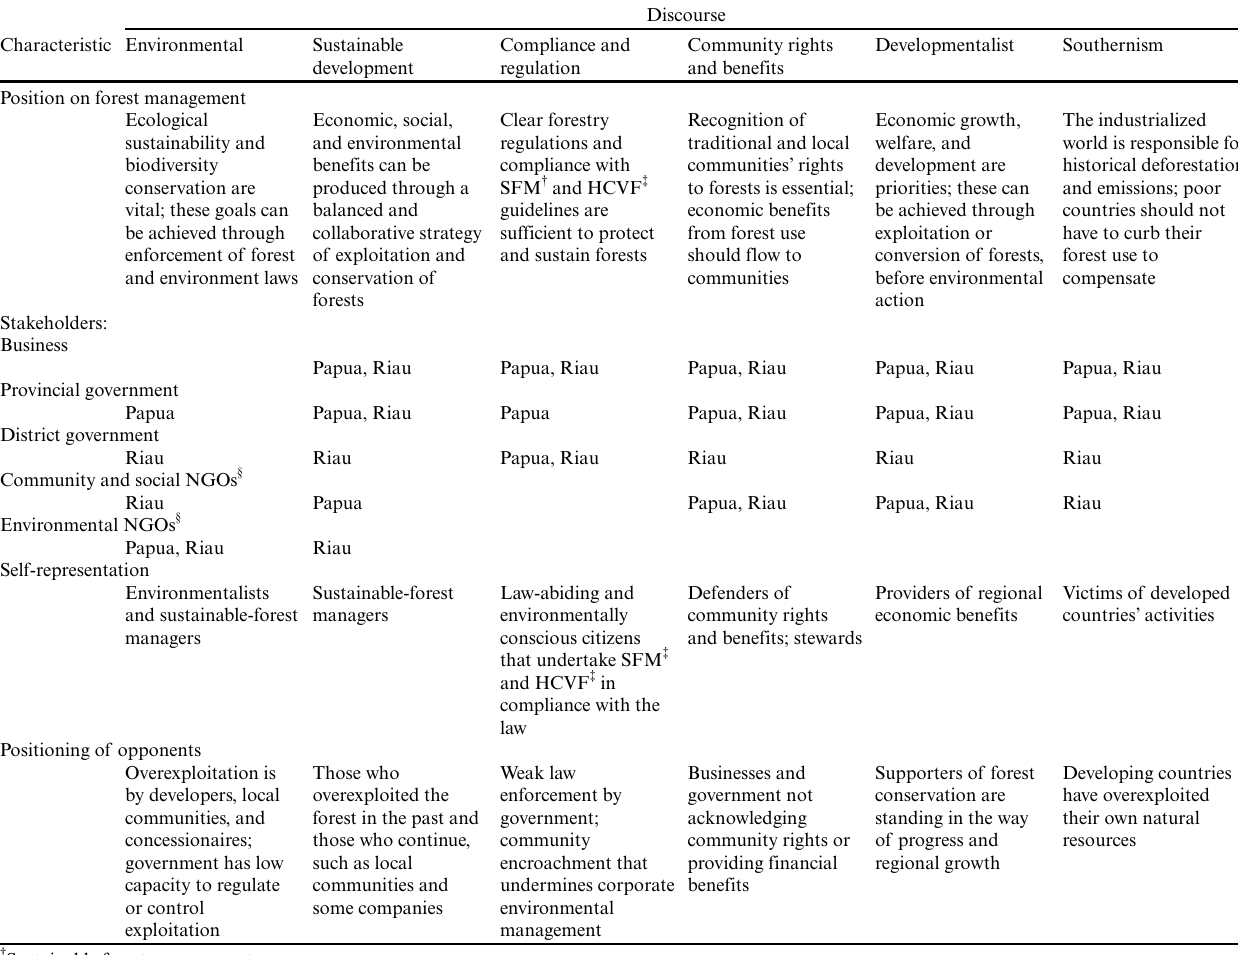
Table 3. Summary of local discourses and how they were used by